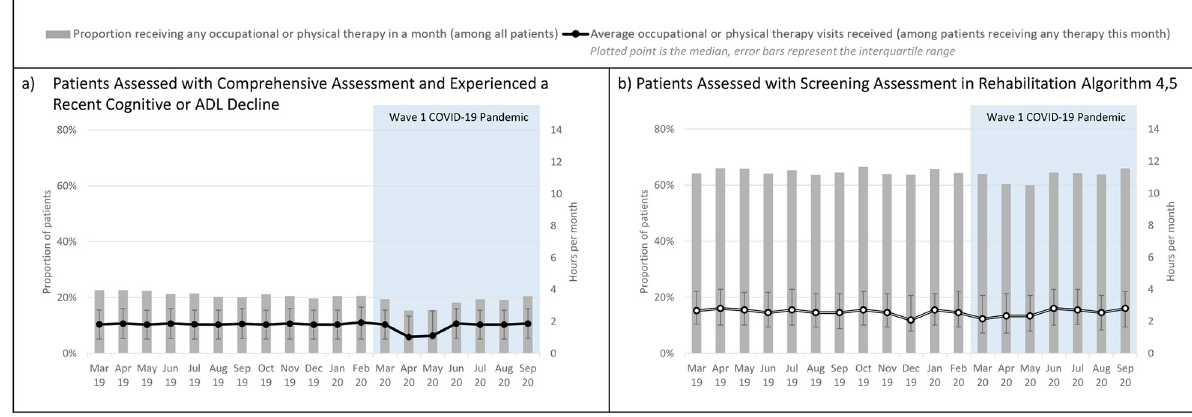
Fig 5. Receipt of occupational or physical therapy among patients with potential rehabilitation needs.